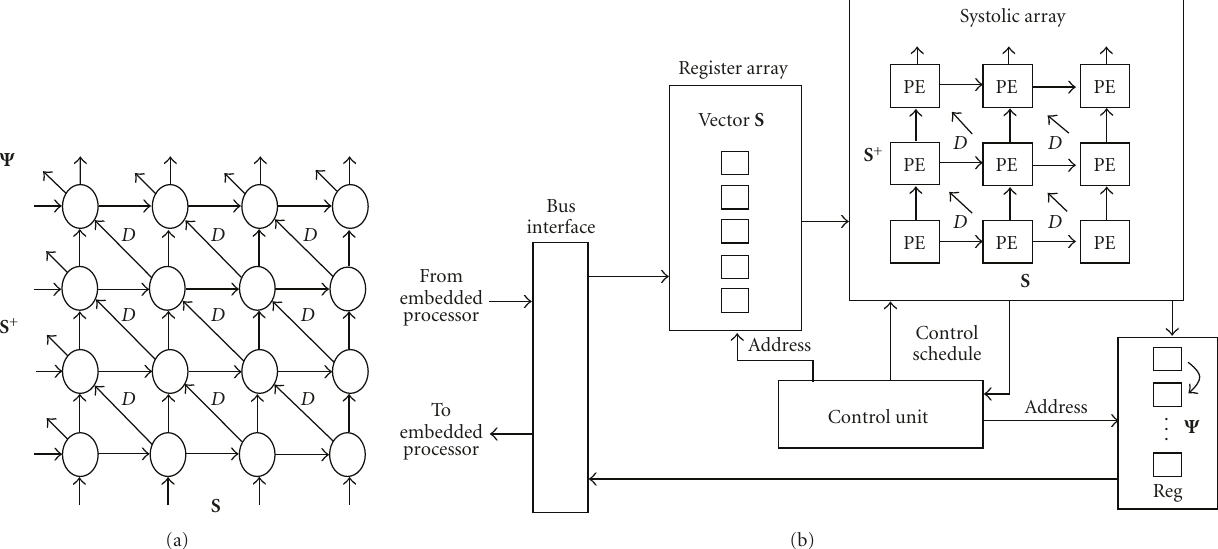
Figure 7: PSM implementation: (a) systolic array for performing the PSM function; (b) PSM coprocessor systolic architecture.